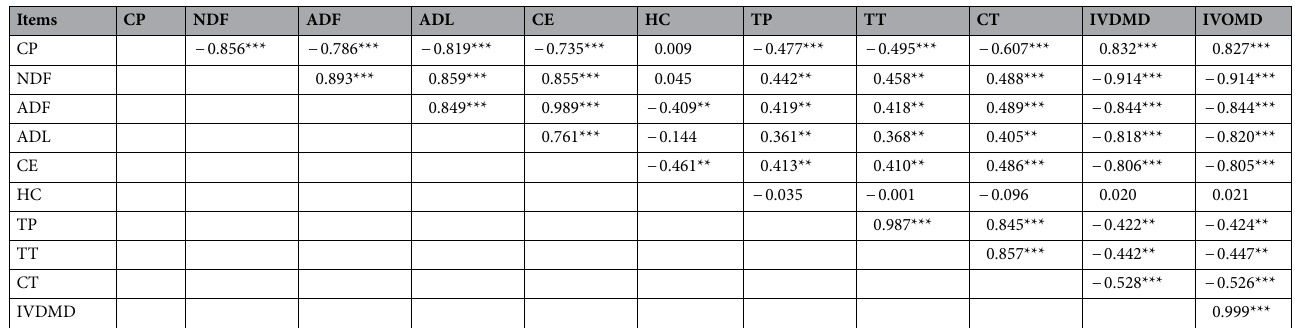
Table 2. Pearson correlations (r) (alongside their significance levels at *, **, ***) between crude proteins (CP) and overall fibre content neutral detergent fibre (NDF), acid detergent fibre (ADF), acid lignin fibre (ADL), cellulose (CEL), hemicellulose (HCL), total phenol (TP) total tannins (TT), condensed tannins (CT), in vitro dry matter digestibility (IVDMD), in vitro organic matter digestibility (IVOMD) (g/kg) of studied ethnobotanical fodder / forage grasses (n = 53). Here *, ** and *** represent significance at P < 0.05, P < 0.01 and P < 0.001